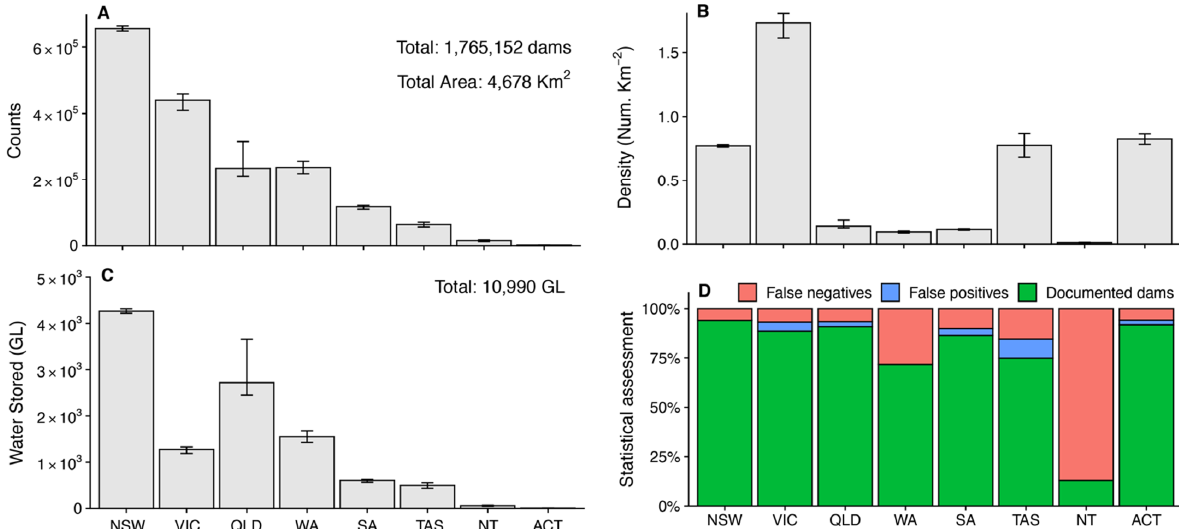
Figure 5. Final statistics for Australian farm dams in each State and Territory. ( A ) Total counts, ( B ) overall densities and ( C ) cumulative water capacities (GL) are calculated after removing unreliable entries (false positives) and adding expected undocumented dams (false negatives). The size and water capacity of undocumented dams were calculated based on manual tracing (Figure 2). Grey bars indicate medians, while error bars represent the bootstrapped 95% confidence intervals. ( D ) Relative contributions of false positives and false negatives compared to the total documented dams in each State and Territory.